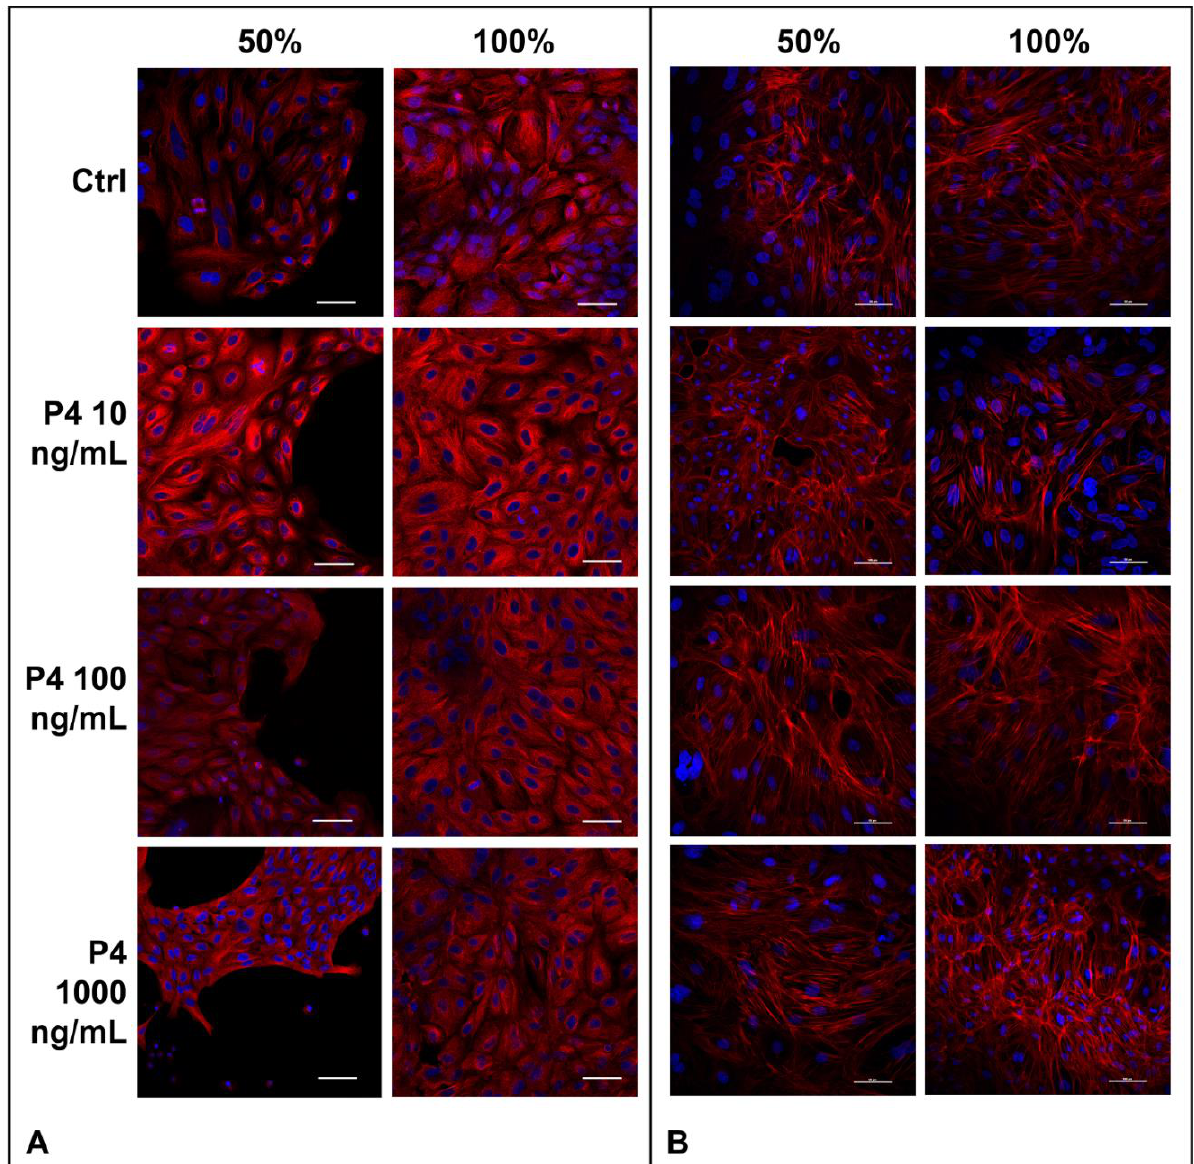
Figure 3. ( A ) Microtubules organization of SOECs. Immunofluorescence analysis of α -tubulin of SOECs after P4 treatment at different confluence time points (50% e 100%) and control condition (CTRL). Monoclonal anti-mouse- α -tubulin antibody and secondary antibody anti-mouse cy3 TRICT- conjugated (red) were used to detect α -tubulin; DAPI was used to stain the nuclei (blue). Three independent experiments were performed. ( B ) Actin filaments of SOECs. Phalloidin staining was used to study the F-actin of SOECs after P4 treatments at different confluence time points (50% e 100%) and control condition (CTRL). DAPI (blue, nuclei), TRITC-conjugated phalloidin (red, F-actin). Three independent experiments were performed.